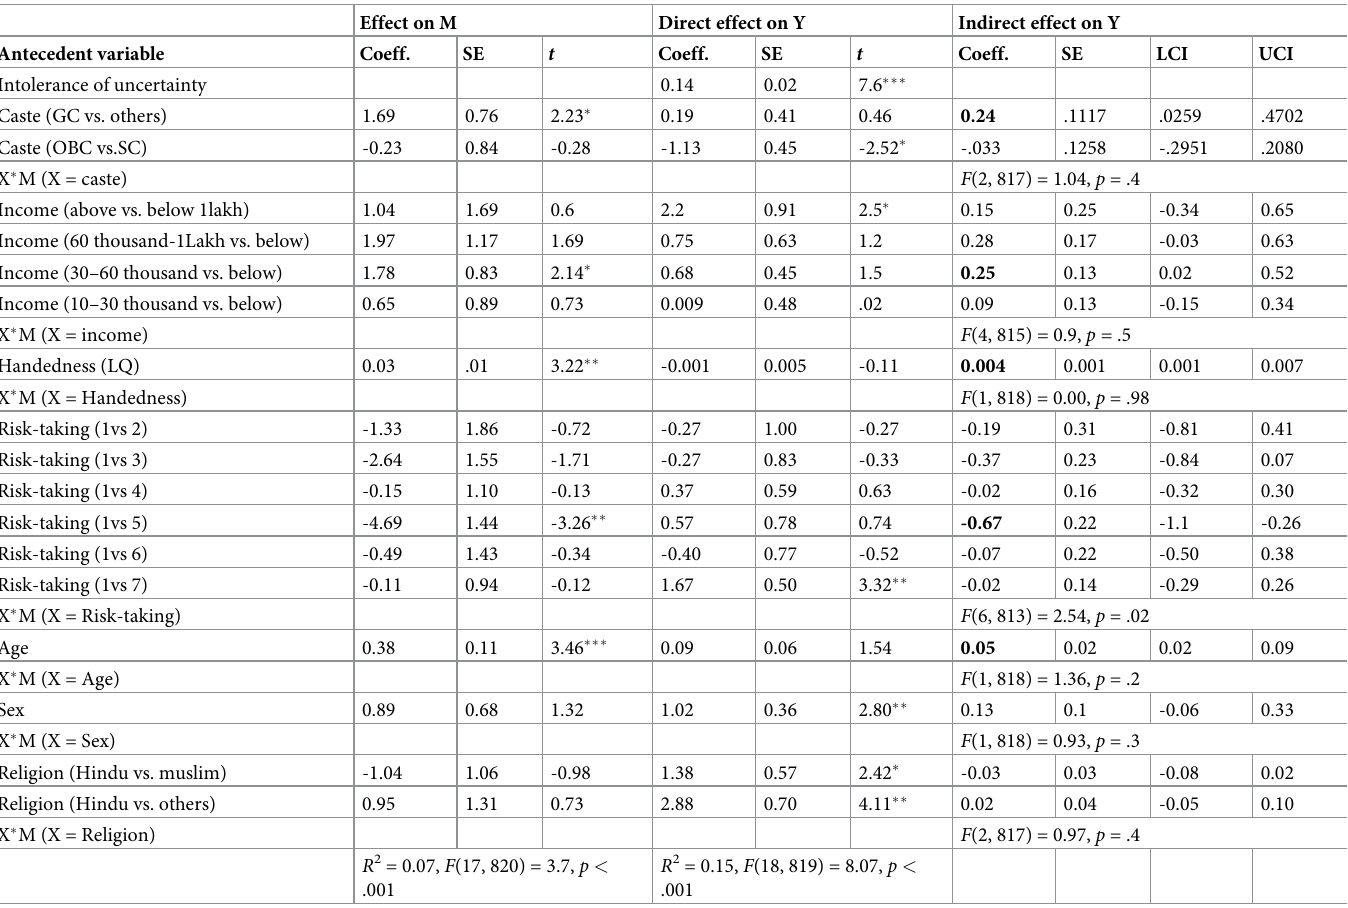
Table 4. The effects (direct and indirect effect) of antecedent and mediation (general IU) variables on believing in the students’ sample. Effect on M Direct effect on Y Indirect effect on